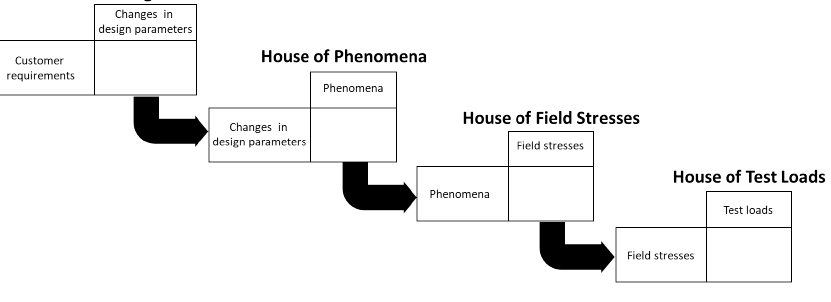
Figure 2. Cascade of Houses of the proposed Scenario-based Noise Deployment (SND)